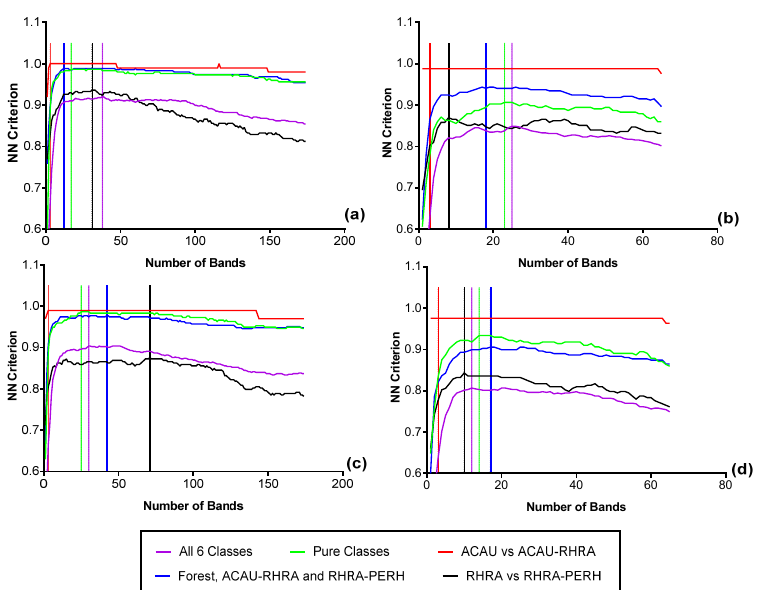
Figure 11. Optimal bands from the FFS for discriminating the six predominant species classes from ( a ) VNIR reflectance (2.5 m), ( b ) SWIR reflectance (2.5 m), ( c ) VNIR reflectance resampled to the coarsest SCM spatial (62.5 m), ( d ) SWIR reflectance resampled to the coarsest SCM spatial resolution (62.5 m).